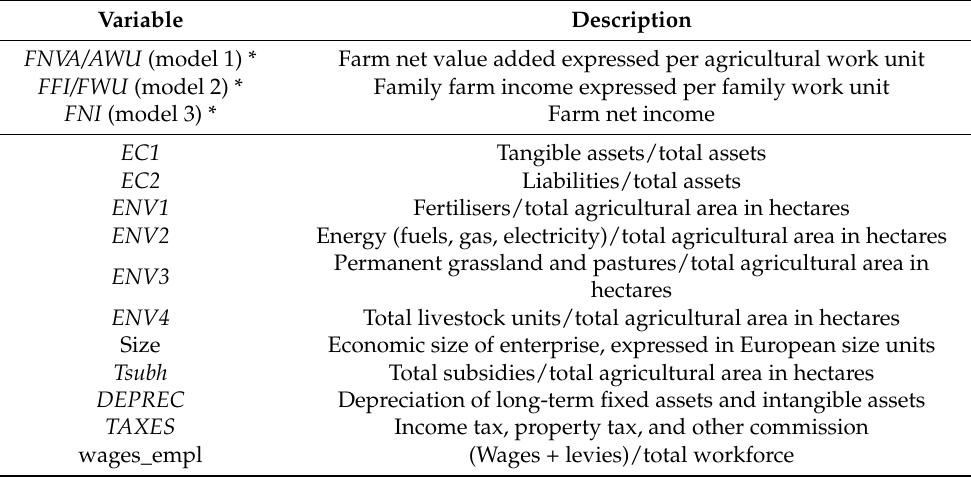
Table 1. Dependent and independent variables in models of the EU’s income